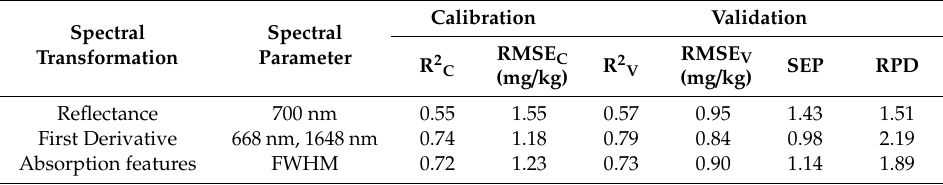
Figure 5. Comparison between the measured As content in experiments and the predicted As content derived from regression models: ( a ) validation model at R 700 , ( b ) validation model at FD 668 and FD 1648 , and ( c ) validation model at FWHM. Table 5. Statistical results of the regression models using calibration and validation subset for the needle spectral parameters.